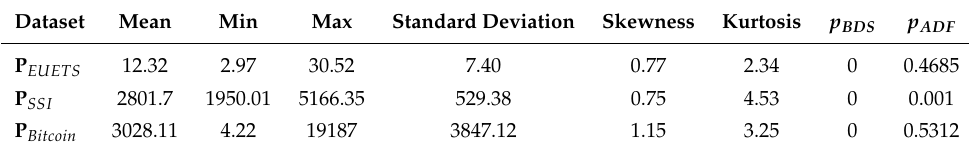
Table 1. Descriptive statistics and statistical tests of three financial time